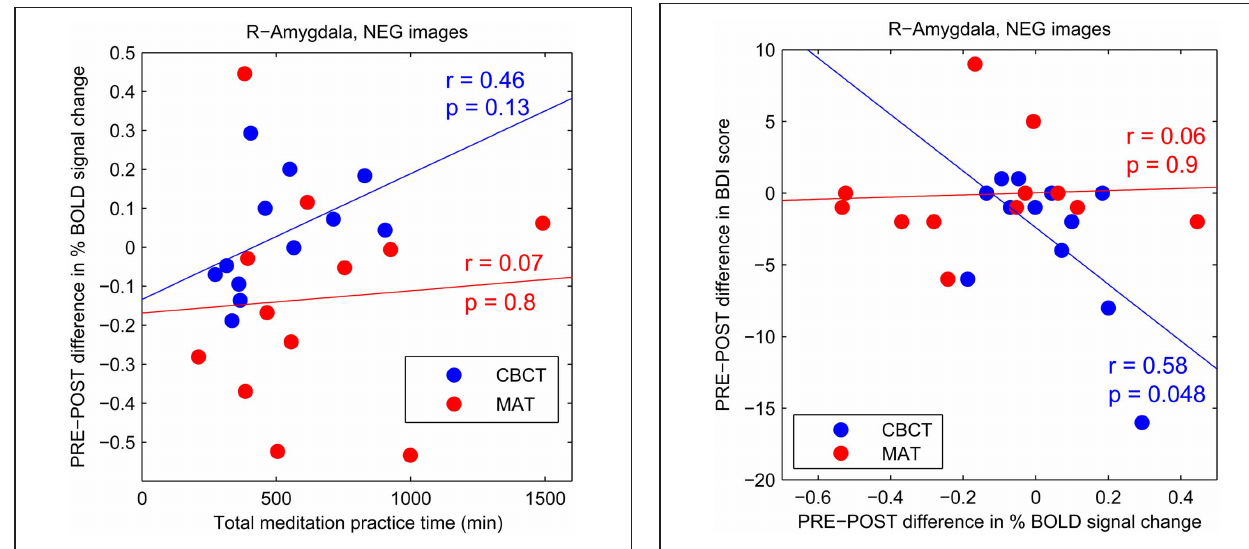
FIGURE 3 | PRE-POST difference in percentage BOLD signal change in right amygdala as a function of total meditation practice time. Each data point corresponds to an individual subject. The CBCT group is shown in blue, the MAT group in red. Linear regression lines are shown in corresponding colors.